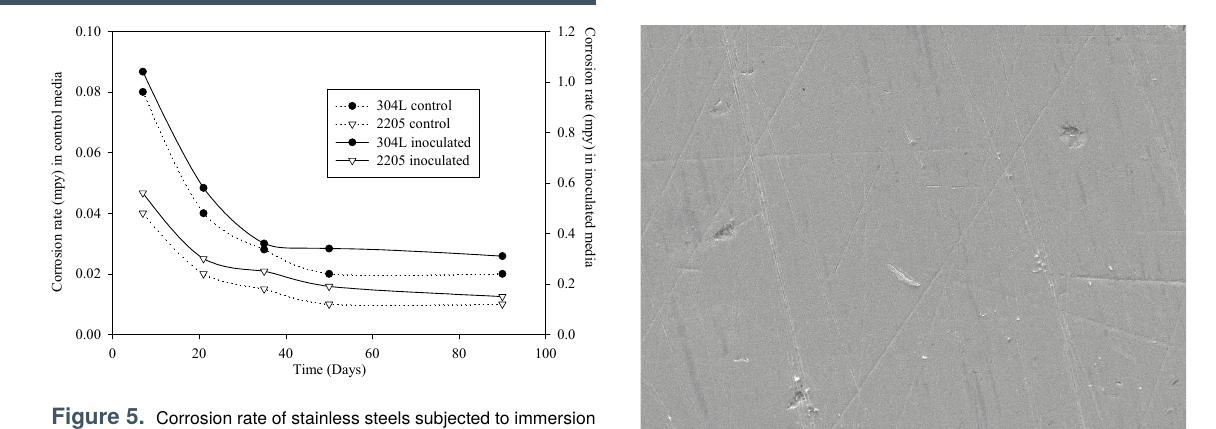
mediaTime Fig. 6 Maximum pit depth in case of stainless steels subjected to immersion tests with replenishment of